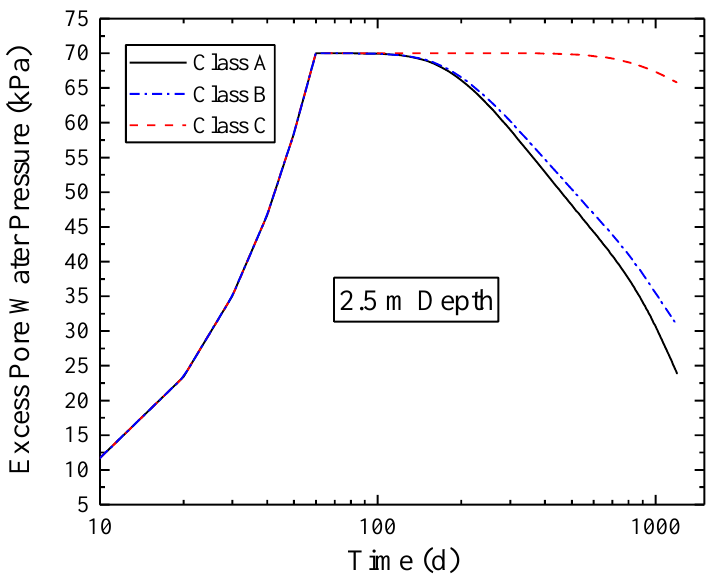
Figure 11. Comparisons of excess pore water pressure at 2.5 m depth.